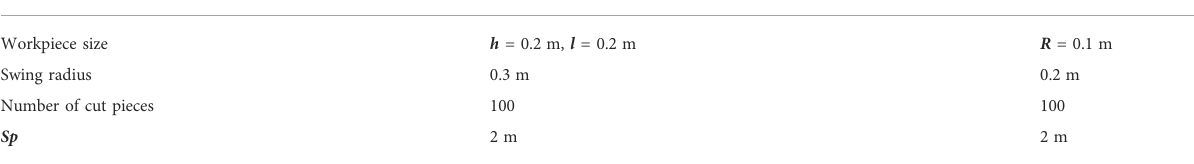
TABLE 2 Simulation workpiece parameters.